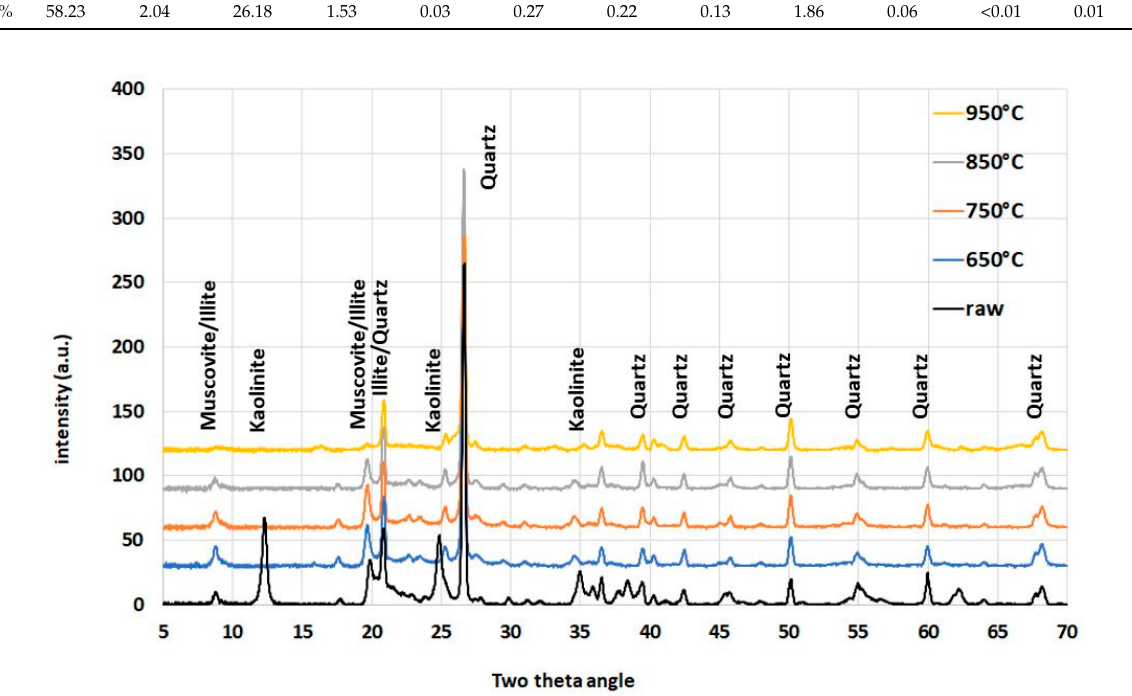
Figure 1. Mineral composition of the clay depending on the calcination